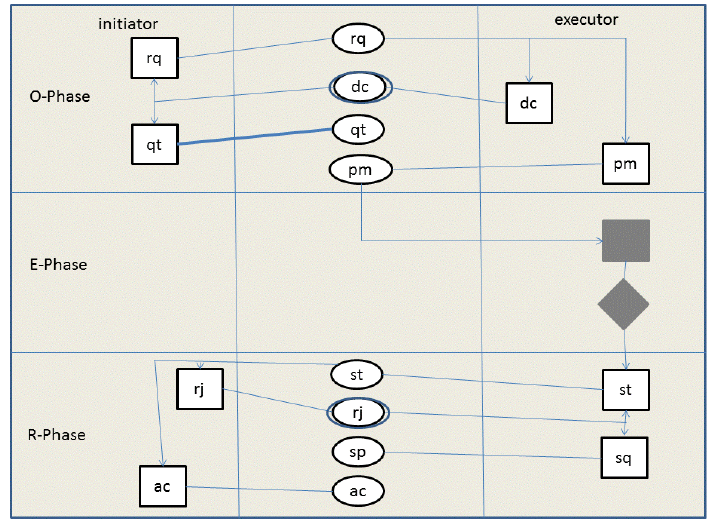
Figure 2. Standard transaction pattern (adapted from [31]) – rq: request, pm: promise, st:state, ac: accept, dc: decline, qt: quit, rj: reject, sp: